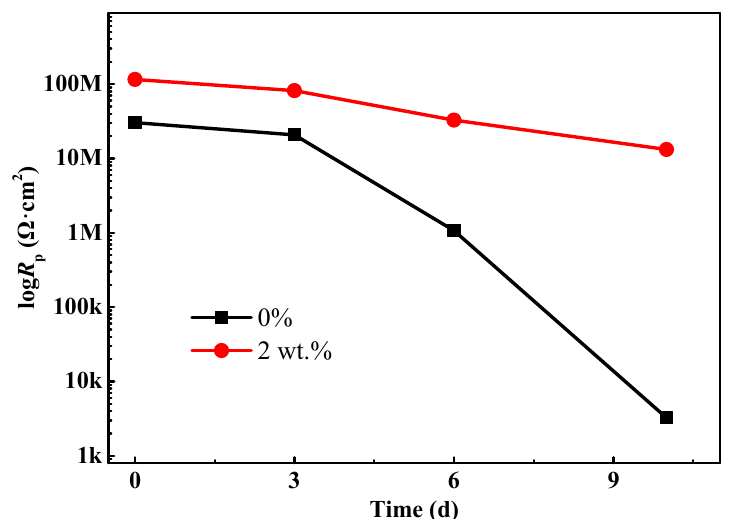
Figure 7. The change trend of the polarization resistance ( R p ) of the waterborne polyurethane coating. The coating porosity ( P ) directly affects the shielding properties and the penetration behavior of the electrolyte. It can be calculated according to Equation (1) [30,31], where R pt represents the coating resistance when the porosity of the coating tends to infinity. It can be obtained through Equation (2). Here, d ( µ m) is the coating thickness. A (cm 2 ) describes the sample area. k 0 is the electric conductivity of the electrolyte. For the 3.5 wt % NaCl solution, it is around 3